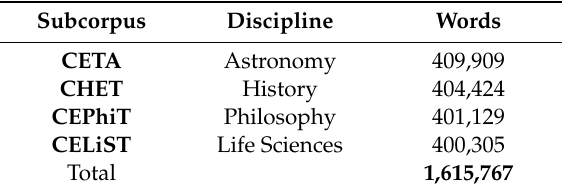
Table 2. Word count per